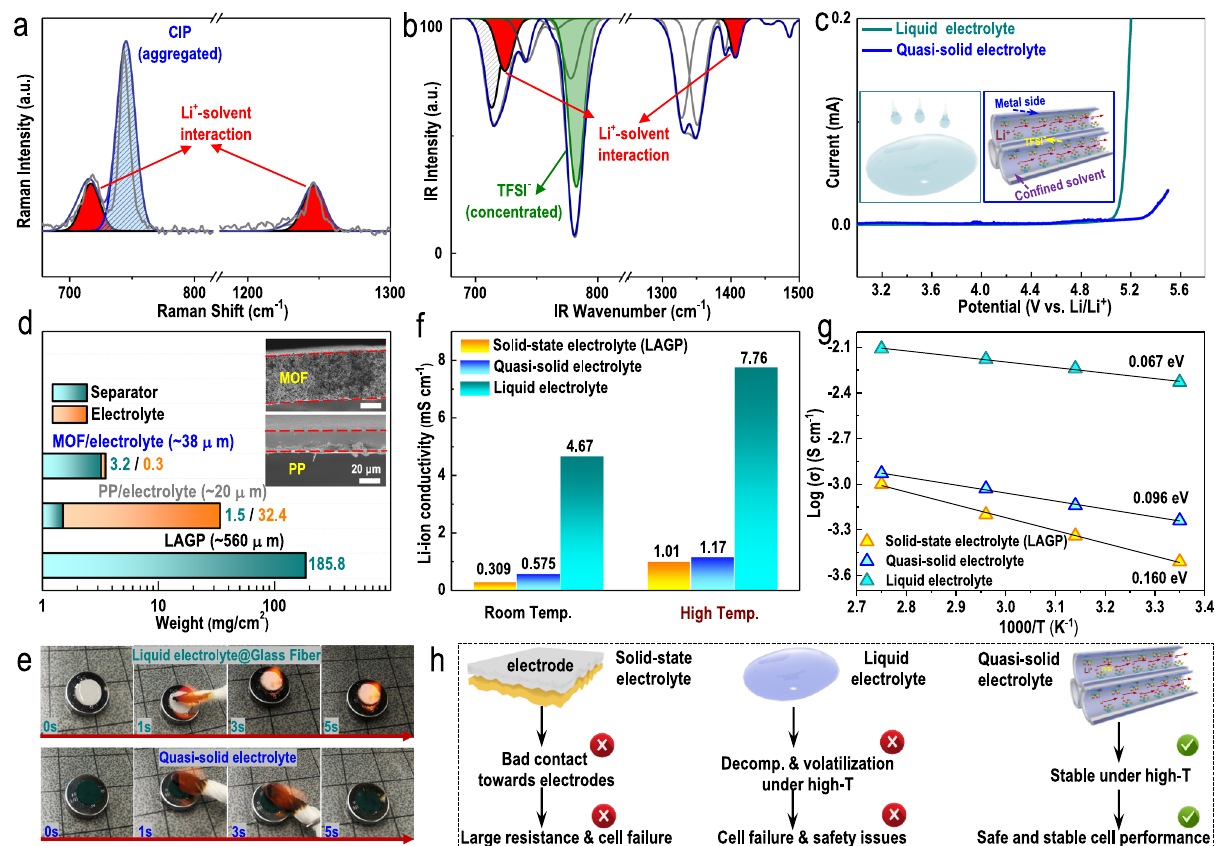
Fig. 3 Physiochemical properties of the MOF-based quasi-solid electrolyte. a Raman spectrum and b Fourier transform infrared spectrum (FT-IR) of the prepared MOF-based quasi-solid electrolyte. c Linear sweep voltammetry (LSV) curves of the two electrolytes (green curve: typical liquid electrolyte; blue curve: MOF-based quasi-solid electrolyte). The inset schematically illustrates the different electrolyte con fi gurations. d Comparison of the thicknesses and qualities of different electrolytes (quasi-solid electrolyte, commercial PP separator typical liquid electrolyte and commercial Li 1.3 Al 0.3 Ge 1.7 (PO 4 ) 3 (LAGP) solid electrolyte). Photographs of ignition tests of e typical liquid electrolyte saturated glass fi bers and the prepared MOF-based quasi-solid electrolyte. f Ion conductivities and the corresponding activation energies g of the solid-state electrolyte, quasi-solid electrolyte and typical liquid electrolyte. h Advantages of the prepared quasi-solid electrolyte in constructing highly safe